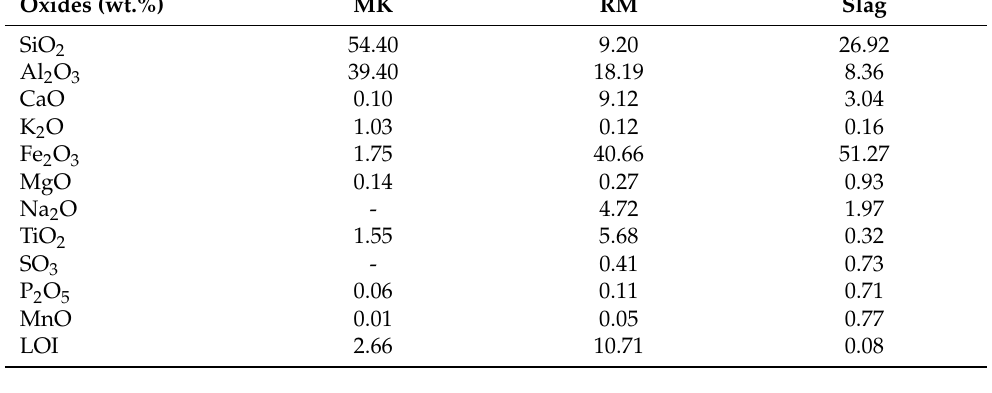
Table 1. Chemical composition from XRF of metakaolin (MK), red mud (RM), and slag. Oxides (wt.%)